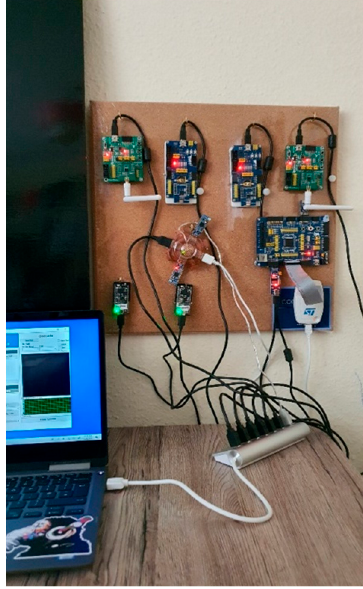
Figure 13. A JosNet Station Capable of Accommodating Multiple Network Technologies within a Single Station